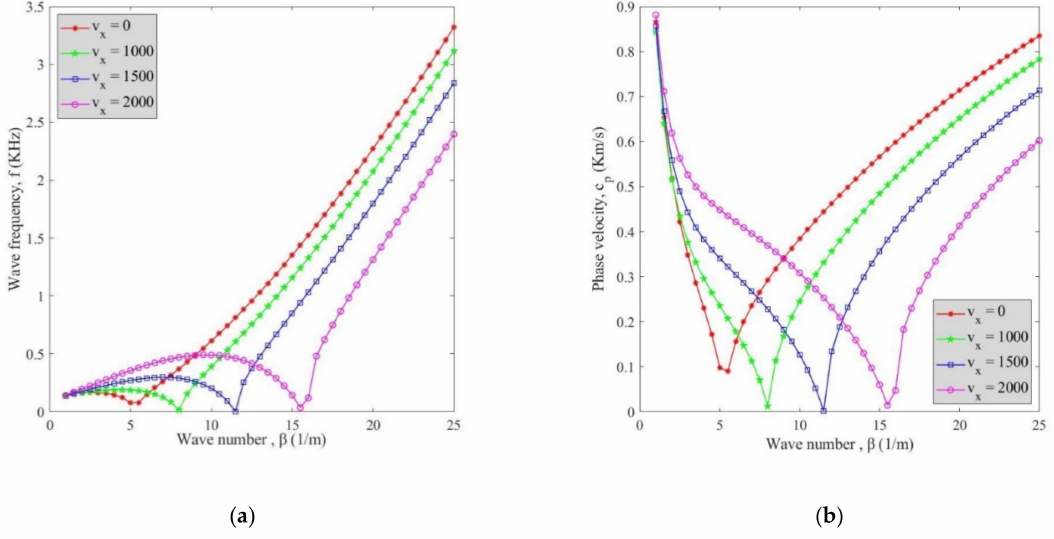
Figure 9. The effect of fluid flow velocities on changes of ( a) wave frequency and ( b ) phase velocity versus wave